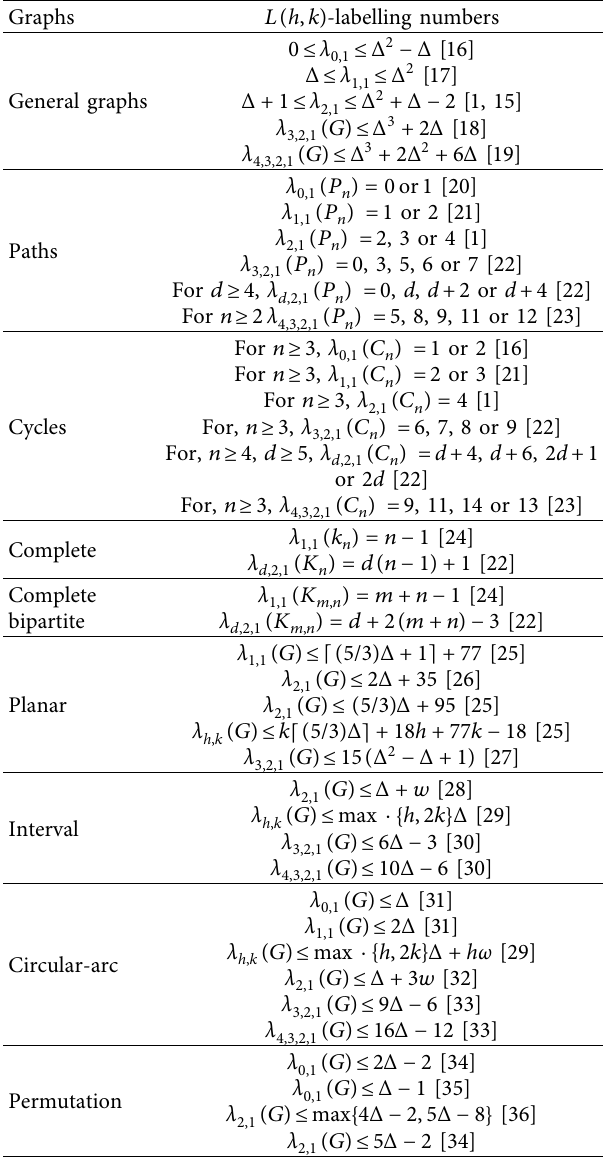
Table 1: Different types of graphs and their upper bounds. Graphs L ( h,k ) -labelling